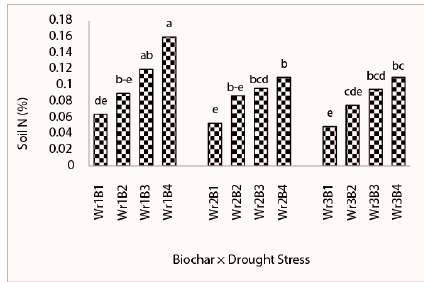
Figure 4 The effects of the interaction of drought stress and biochar on soil N concentration. Mean values with the same letters are not significantly different at p ≤ 0.05 according to LSD test.